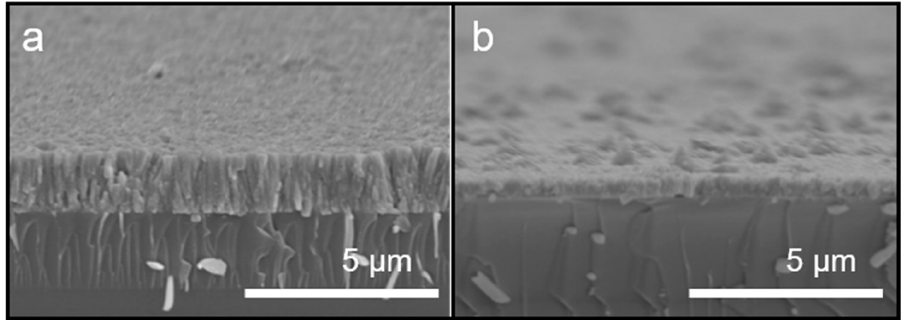
Figure 4. Cross-sectional SEM images of ZnO coatings prepared using the atmospheric microplasma-assisted ultrasonic spray pyrolysis process at ( a ) 400 °C, and ( b ) 400 °C with vacuum annealing.